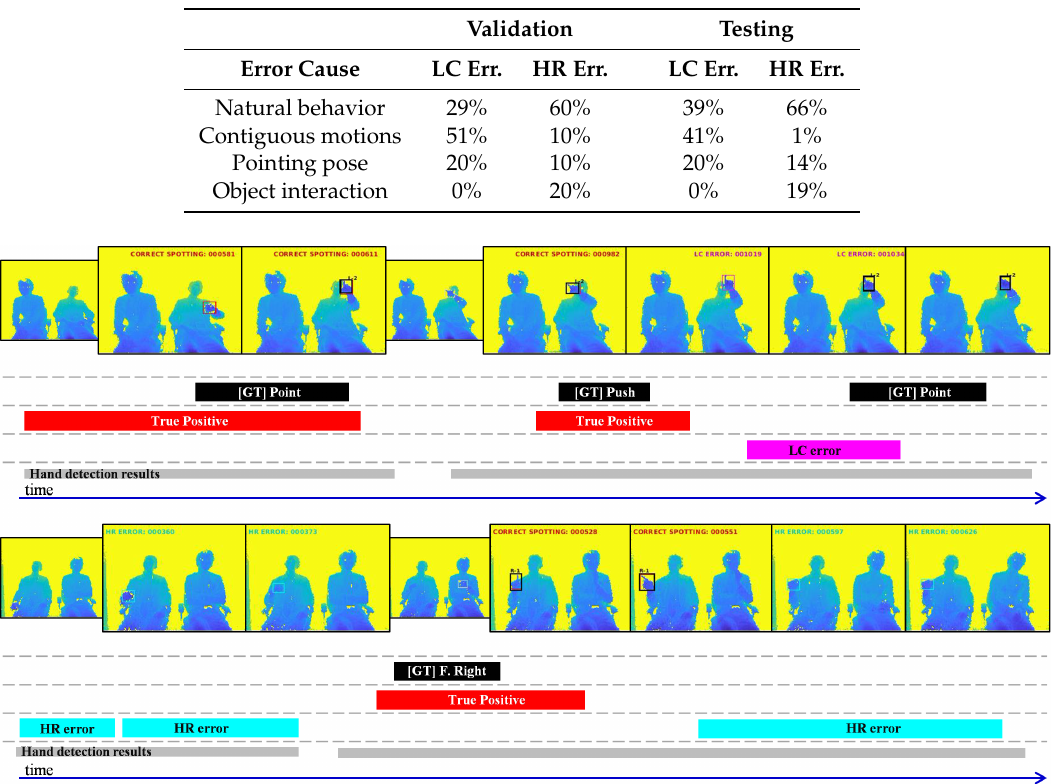
Table 5. Analysis of error cause of LC and HR of our multi-stream approach.